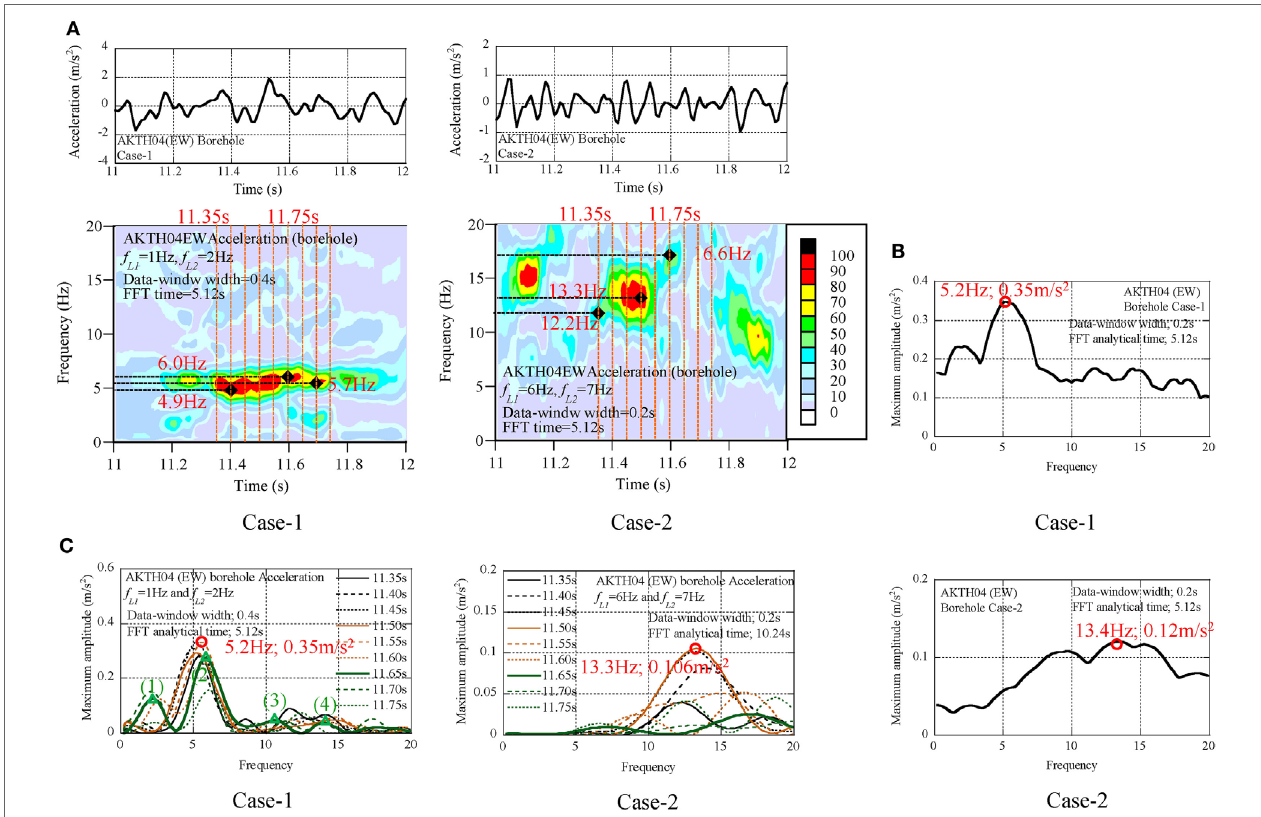
FigUre 9 | Seismic records of AKTH04 (EW); borehole, (a) Non-stationary Fourier spectra, (b) Maximum amplitude spectra, (c) Transient process of amplitude spectra.